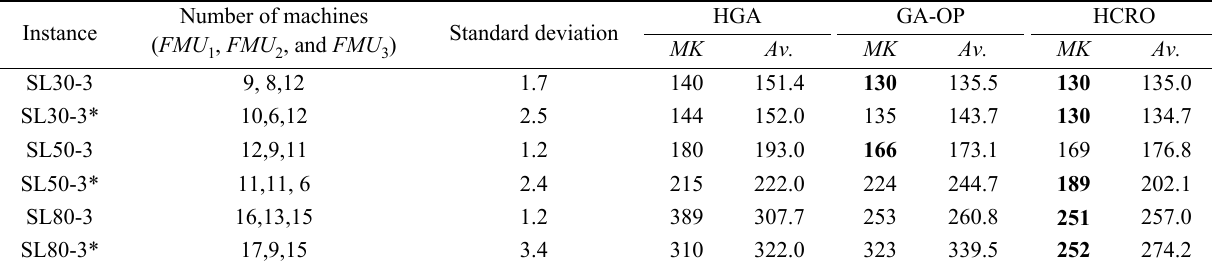
Table 12 Influence of the number of machines in the FMUs on the